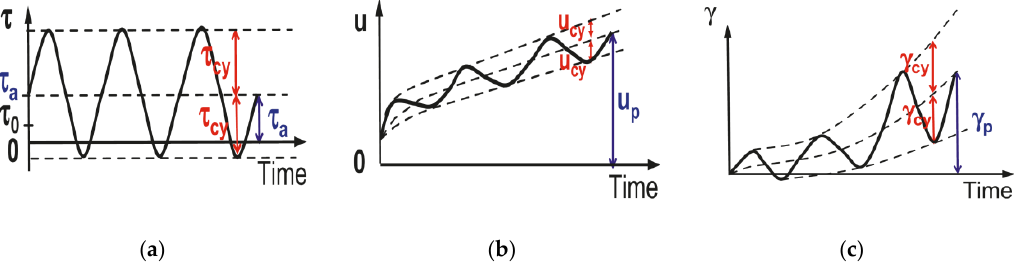
Figure 2. Pore pressure and shear strain as a function of time under undrained cyclic loading: ( a ) Cyclic and average shear stresses; ( b ) Pore pressure generation; ( c ) Cyclic and permanent shear strains [10]. Here, u is the pore pressure, γ is the shear strain, and τ 0 is the initial consolidation shear stress.